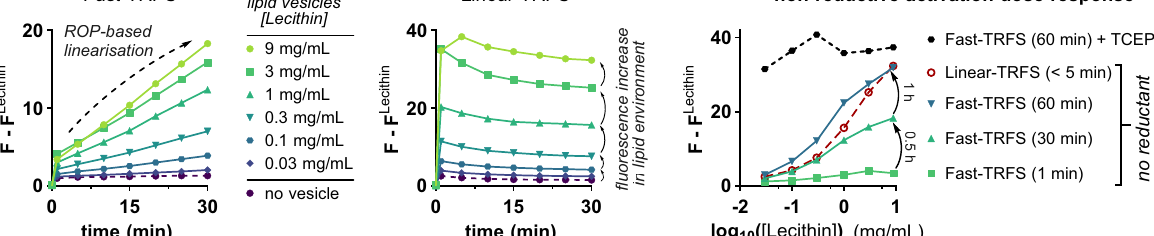
Fig. 6 The fl uorescence of non-cargo-releasing 1,2-dithiolane Fast-TRFS activates in the absence of TrxR and of reductants, after partitioning into membranes: coherent with strain-promoted oligomerisation and environment-dependent fl uorescence. a Weak, environment-dependently fl uorescent Fast-TRFS 18 ; and strong environment-dependently fl uorescent compounds dithiol-TRFS (its reduction product) and Linear-TRFS (a reference compound). b The inhomogenous media of cellular assays may be closer modelled with lipid vesicle suspensions than as an all-aqueous system. c Extractive concentration of Fast-TRFS into lipid membranes may drive concentration-dependent, strain-promoted ring-opening polymerisation (ROP) to nonstrained polydisul fi de PolyLinear-TRFS , whose fl uorescence may mimic that of nonstrained monodisul fi de Linear-TRFS . Thus, ROP may be a non-reductive mechanism for fl uorescence turn-on of Fast-TRFS . d Fast-TRFS and Linear-TRFS (each 10 µ M) incubated with lecithin vesicles. After 60 min, TCEP (0.1 mM) was added to benchmark complete reduction. (Representative example from 2 independent experiments; full data in Supplementary